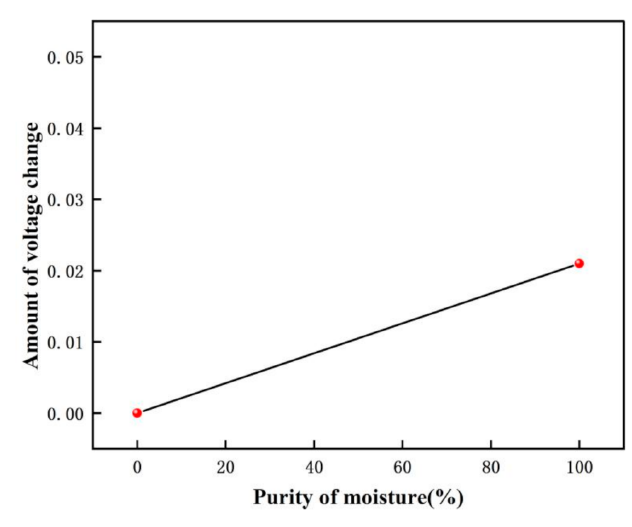
Figure 29. The voltage variation graph for different purity moisture environments.